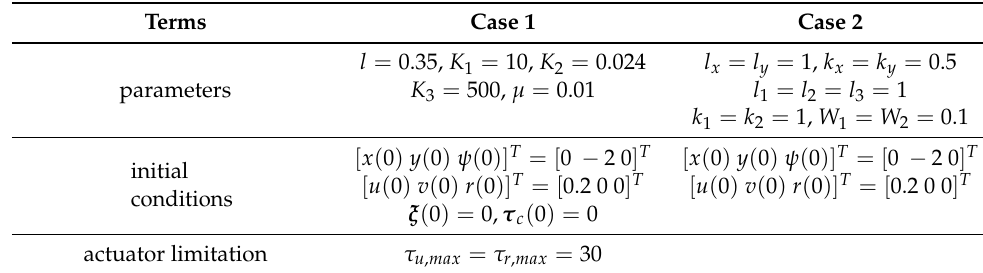
Table 1. Settings in Case 1 and Case